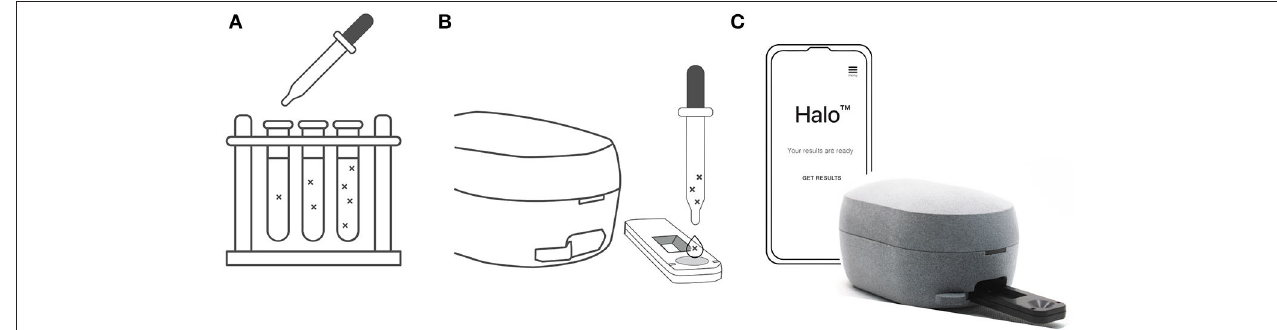
FIGURE 1 | (A) SARS-CoV-2 stocks were diluted with simulated nasal matrix. Serial dilutions were then prepared to assess the preliminary limit of detection for each strain of the virus. (B) 80 µ l of a given dilution was then added dropwise to the assay cassette via pipette and the assay developed for 15 mins. (C) The cassette was then inserted into the Halo reader to record the test line